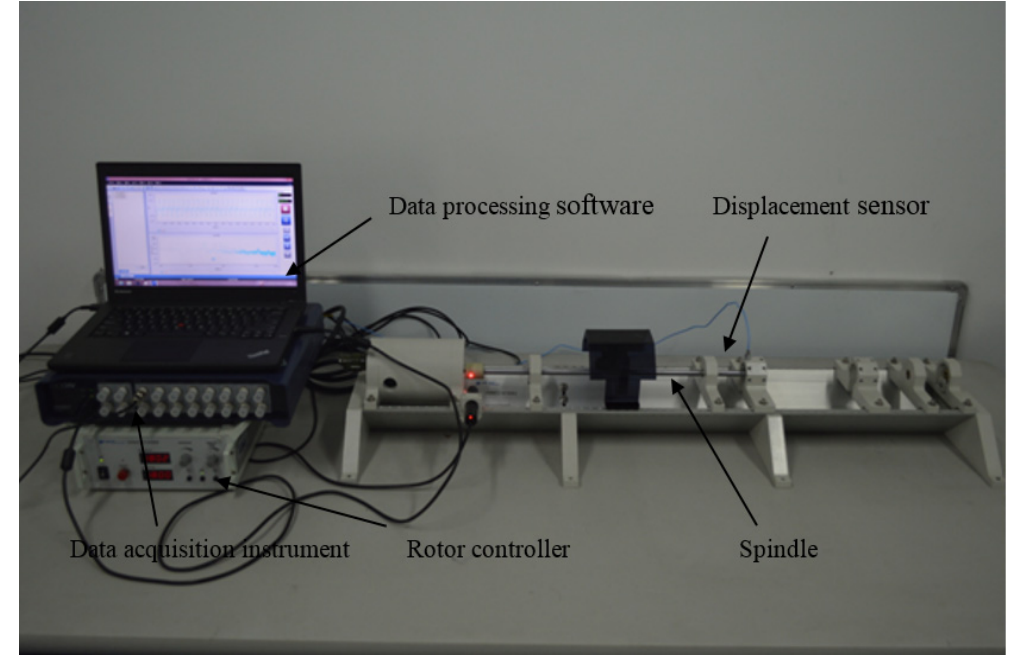
Figure 9. The experimental setup of a rotor ‐ bearing system under normal load conditions.